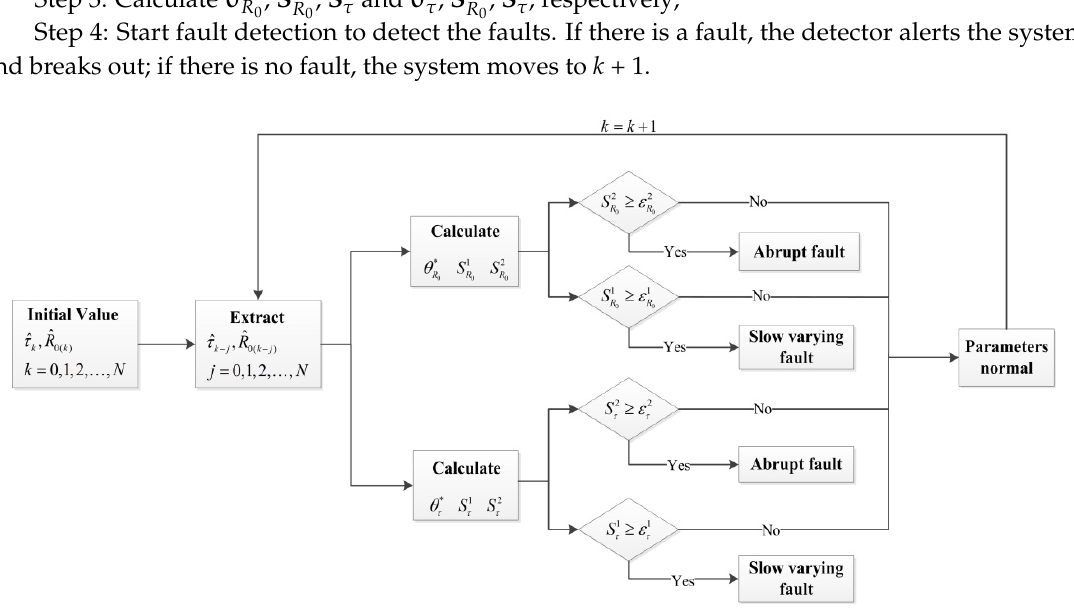
Figure 3. Parameter ‐ biased fault diagnosis process of battery cell. Figure 3. Parameter-biased fault diagnosis process of battery